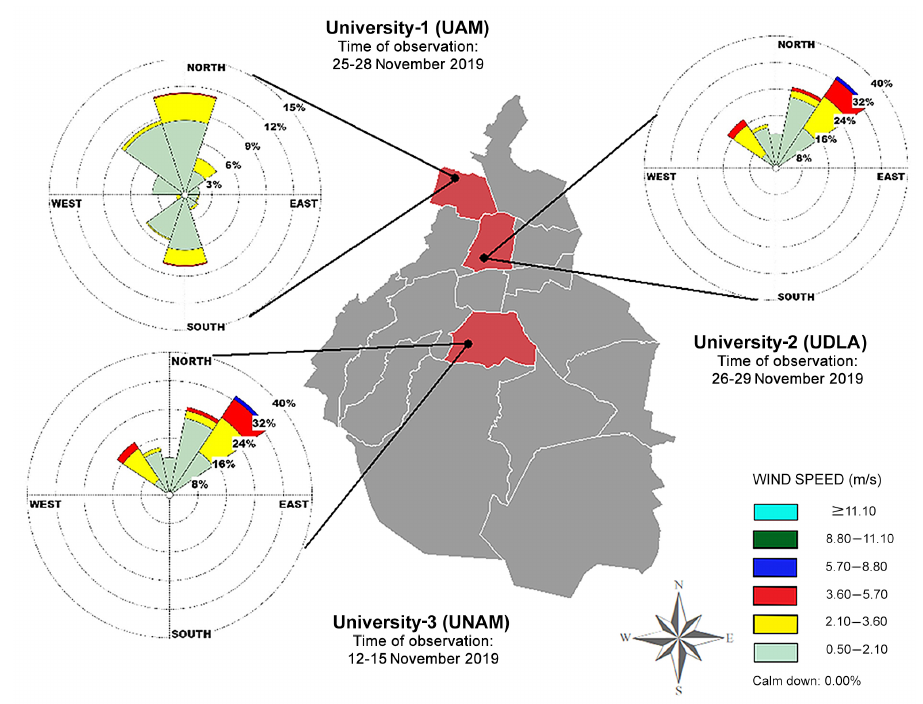
Figure 7. Fall sampling campaign wind roses: University-1 (UAM), University-2 (UDLA) and University-3 (UNAM).